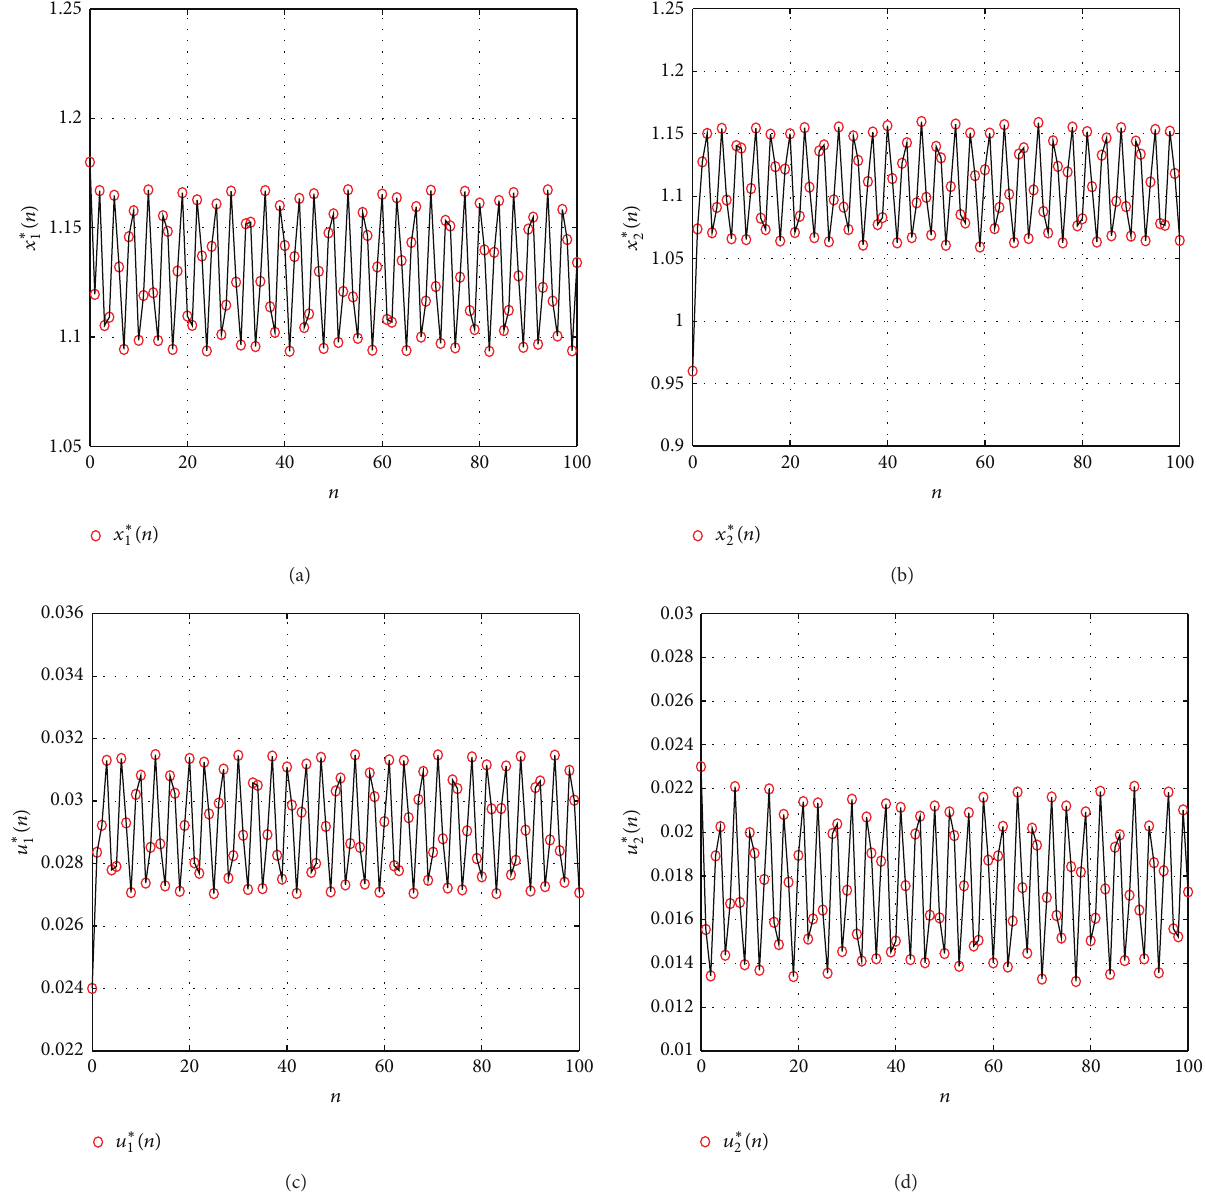
Figure 1: Positive almost periodic solution of system (62). (a)–(d) Time-series of 𝑥 ∗ 1 (𝑛), 𝑥 ∗ 2 (𝑛), 𝑢 ∗ 1 (𝑛) , and 𝑢 ∗ 2 (𝑛) with initial values 𝑥 ∗ 1 (0) = (0) = 0.96, 𝑢 ∗ (0) = 0.024, and 𝑢 ∗ (0) = 0.023 for 𝑛 ∈ [0, 100] , 1.18, 𝑥 ∗ 2 1 2